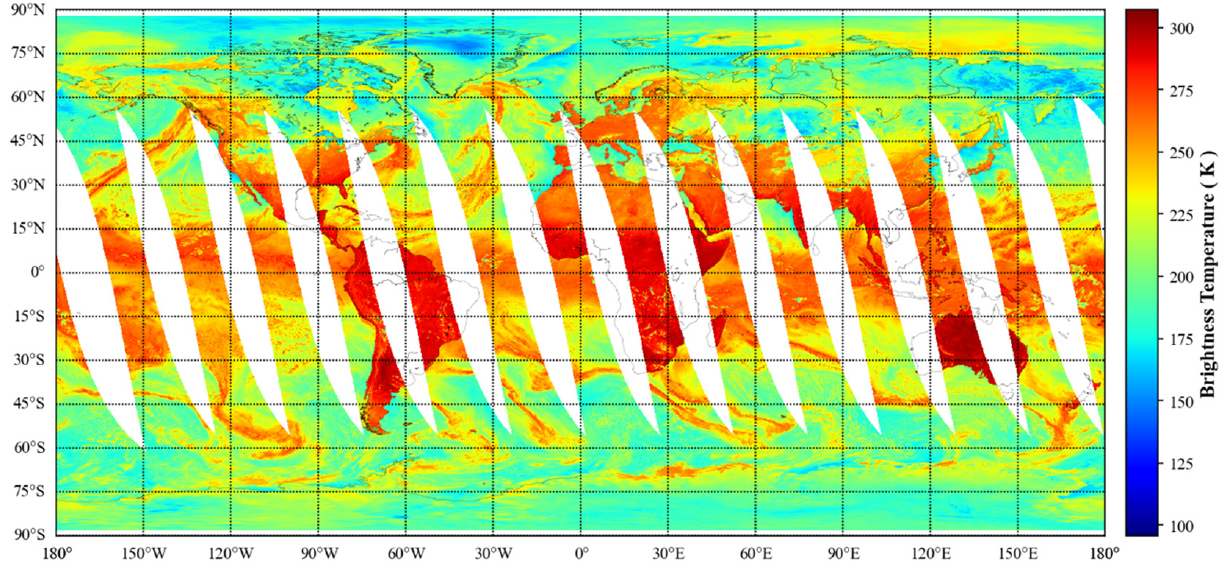
Figure 1. The FY ‐ 3D MWRI ascending brightness temperature on 1 January 2019. Figure 1. The FY-3D MWRI ascending brightness temperature on 1 January 2019. In addition to the FY-3D MWRI images, two land/sea mask datasets are used in this study. One is the Global Self-consistent, Hierarchical, High-resolution Shoreline (GSHHS) provided by University of Hawai’i and NOAA Laboratory for Satellite Altimetry [27]. It was amalgamated from World Vector Shorelines, CIA World Data Bank II, and Atlas of the Cryosphere. The latest data files for version 2.3.7 were released on 15 June 2017. The other dataset is the LandSeaMask dataset provided by the National Satellite Meteorological Center (NSMC), China Meteorological Administration. NSMC transfers the GSHHS data from the ESRI vector to the LandSeaMask raster format with the same format and spatial resolution as the FY-3D MWRI images. LandSeaMask is used to correct the geolocation errors of FY-3D MWRI images, while GSHHS is used to assess the geolocation errors of the corrected FY-3D MWRI